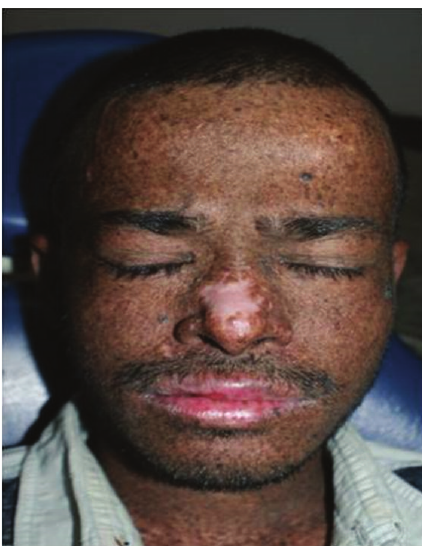
Figure 1: Lentigines (freckle-like pigmentation) on sun-exposed areas of face.